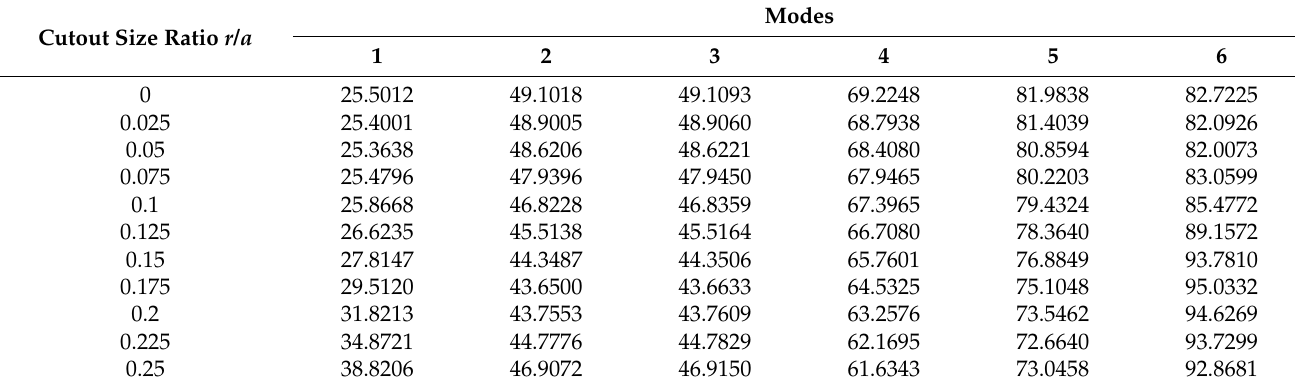
Table 8. The first six non-dimensional frequency parameters of the FGMs square plate with diverse cutout sizes. Cutout Size Ratio r/a